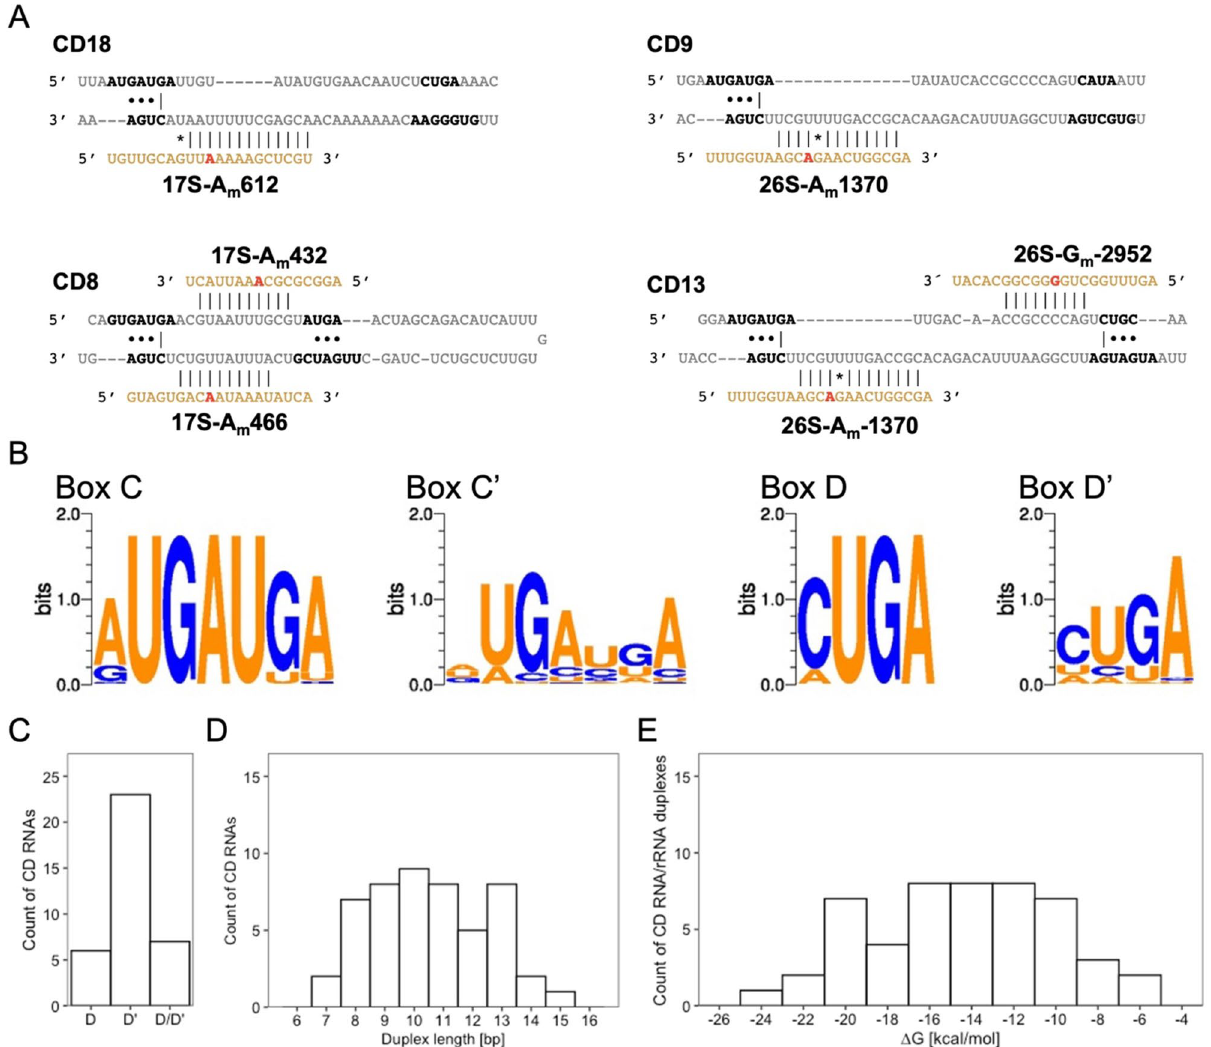
Figure 5. Features of CD RNAs in D. discoideum . ( A ) Examples of CD RNAs guiding 2 ′ - O -Me at one or two rRNA positions. Single (top) and double (bottom) usage of D boxes of selected CD RNAs guiding positions in the 17S (left) and the 26S rRNA (right). Shown are CD RNA sequences (grey) with nucleotides involved in the formation of the k-turn (black). The guided part of the rRNA is shown in orange with the methylated residue highlighted in red. Intra- and intermolecular interactions are denoted for Watson–Crick (|) and G/U base pairing (*), as are the A/G and U/U base pairs (•) involved in the formation of the k-turn. ( B ) Conservation of C, C ′ , D and D ′ box sequences shown with WebLogo 60 . ( C ) Distribution of CD RNAs using box D, D ′ or both. Duplex lengths (in bp; D ) and minimal free energies ΔG (in kcal/mol; E ) of the interaction between CD RNA and the guided rRNA